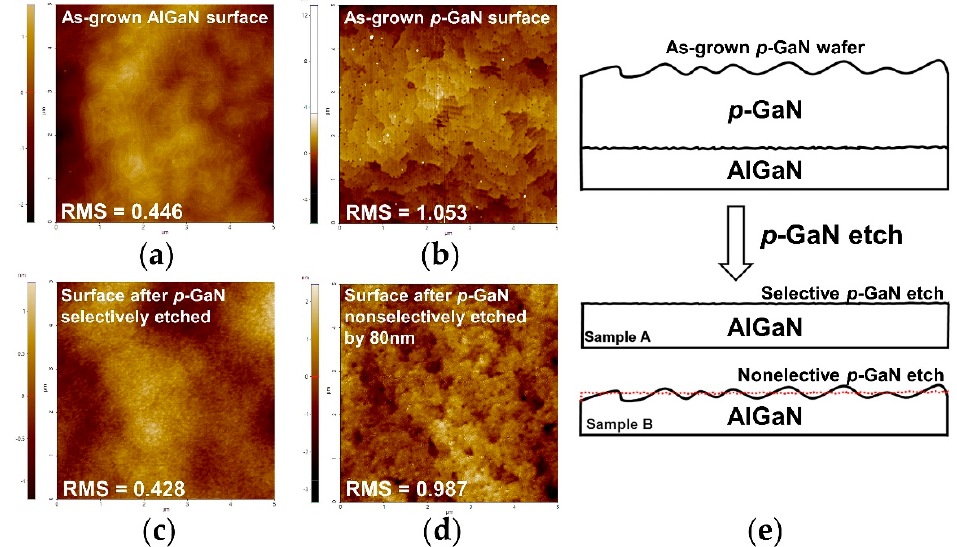
Figure 6. Surface morphology of ( a ) as-grown AlGaN surface, ( b ) as-grown p -GaN surface, ( c ) sample A ( p -GaN selectively etched) and ( d ) sample B ( p -GaN nonselectively etched), ( e ) diagram to illustrate surface morphology for samples A and B.